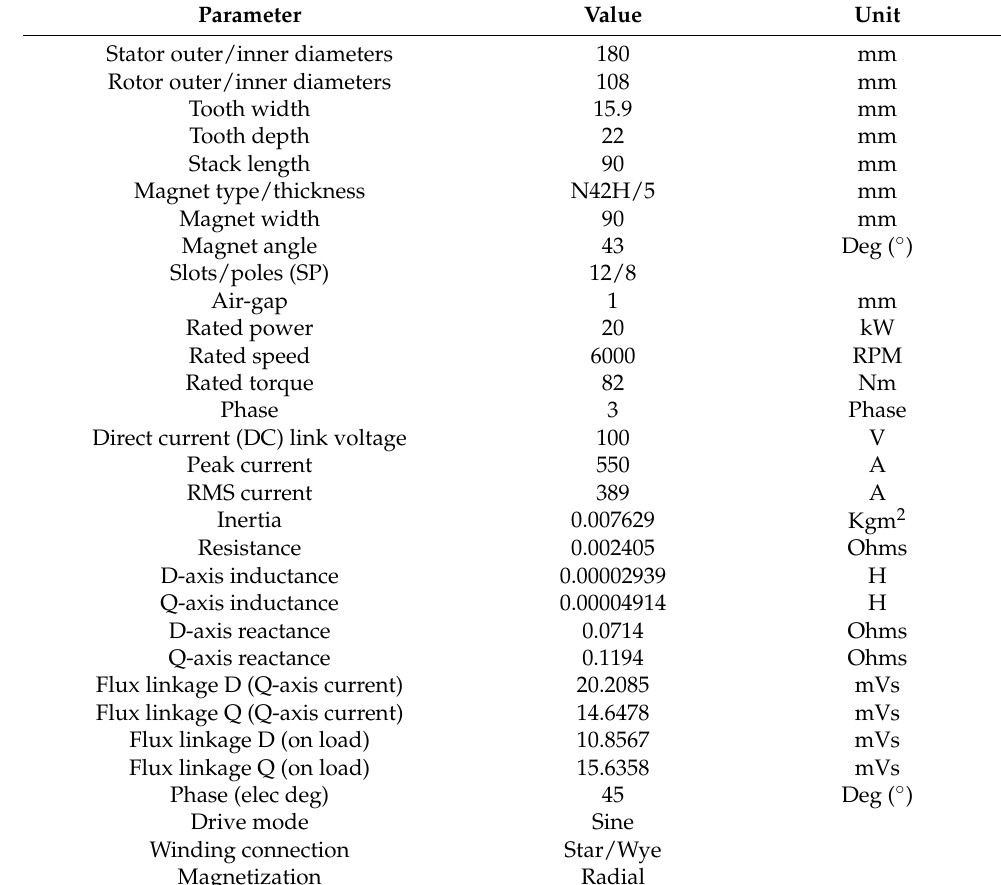
Table 1. Specifications of the proposed interior permanent magnet synchronous machine (IPMSM).